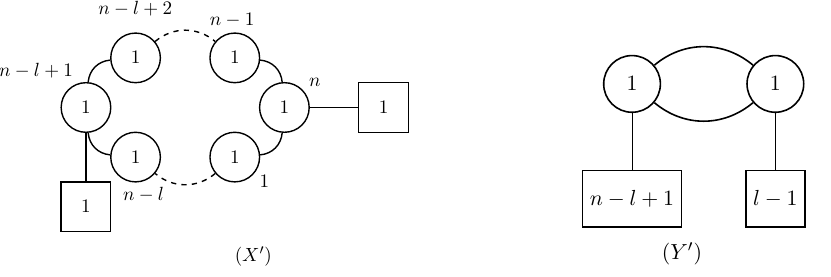
Figure 15 . b A n − 1 quiver X 0 with two fundamental hypermultiplets, and its mirror Y 0 which is an b A 1 quiver with a total of n fundamental